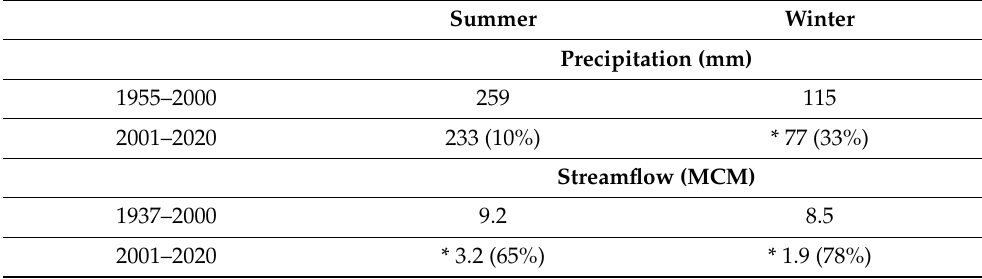
Table 1. Observed average summer and winter precipitation (mm) in USC-00025924 and streamflow (MCM) in USGS-09480500. The square parentheses indicate the percent reduction of the averages for the precipitation and streamflow respectively from 1955–2000 and 1937–2000 to